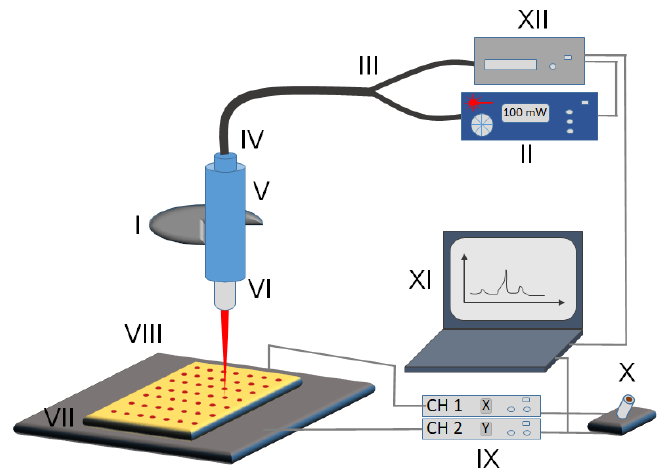
Figure 1. Schematic of the micro Raman reader imaging setup. (I) Objective holder of the microscope frame, (II) laser controller, (III) optical fiber, (IV) Raman probe, (V) Raman probe holder, (VI) laser objective, (VII) sample slide, (VIII) 2-dimensional translatable stage, (IX) BBD202 stage controller with x and y channels separately, (X) joystick for manual control of the stage, (XI) computer controlling both spectrometer and stage, (XII) Raman-HR-TEC spectrometer.